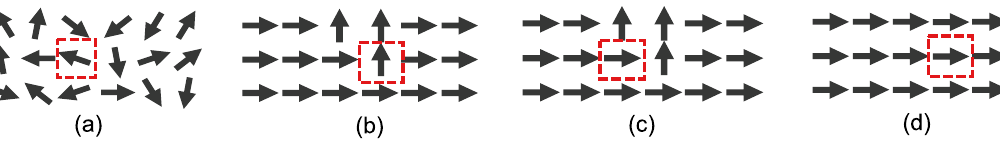
Figure 6. The likelihood value is different as local image regularities vary. ( a ) p = 0, the target pixel cannot be a Gestalt edge. ( b ) p = 0.17, a rather low likelihood, the target pixel is unlikely a Gestalt edge, could be a noise. ( c ) p = 0.88, the target pixel is very likely a Gestalt edge. (d) p = 1, perfect likelihood, the target pixel is undoubtedly a Gestalt